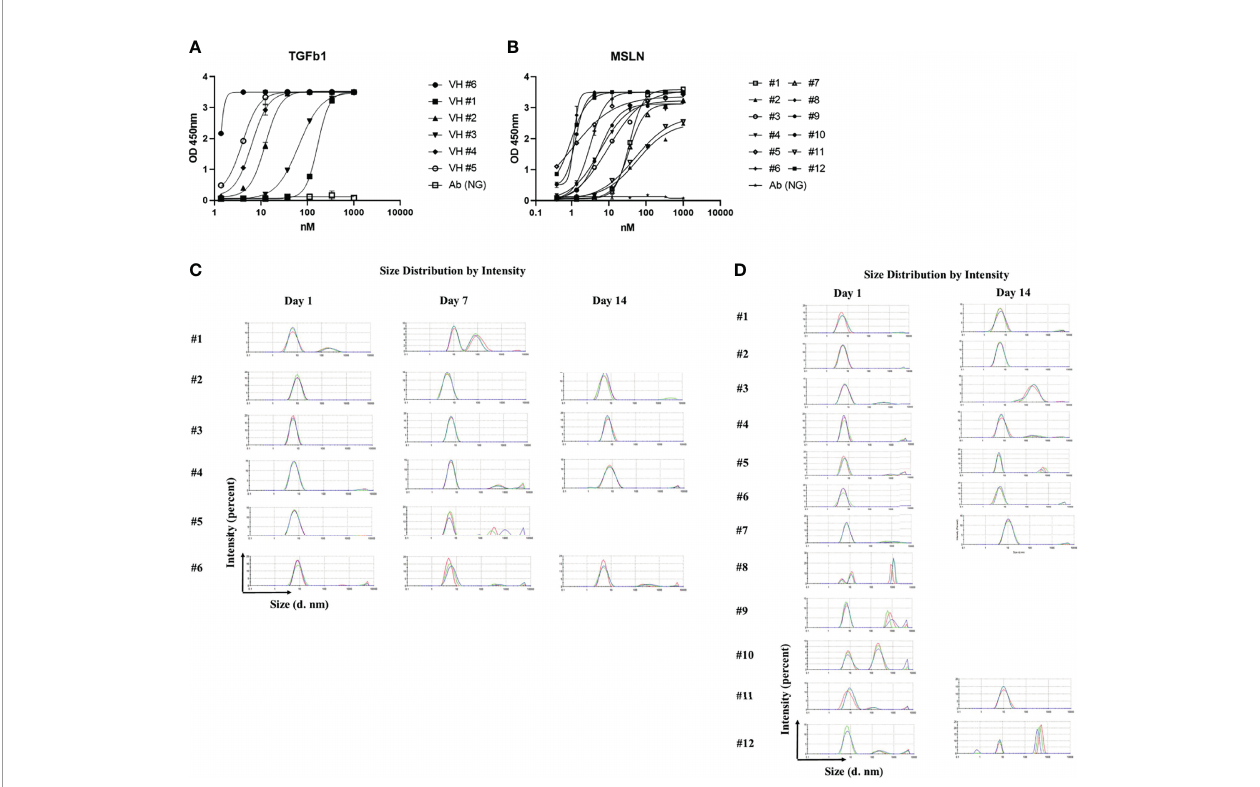
FIGURE 2 | Characterization of constructed library by bio-panning against TGFb1 and MSLN. (A) ELISA of binders against TGFb1; (B) ELISA of binders against MSLN; (C) Dynamic light scattering analysis for evaluation of the aggregation propensity of the TGFb1 speci fi c VH domains; 3 different colors represent 3 different repeats; (D) Dynamic light scattering analysis for evaluation of the aggregation propensity of the MSLN speci fi c VH domains, 3 different colors represent 3 different